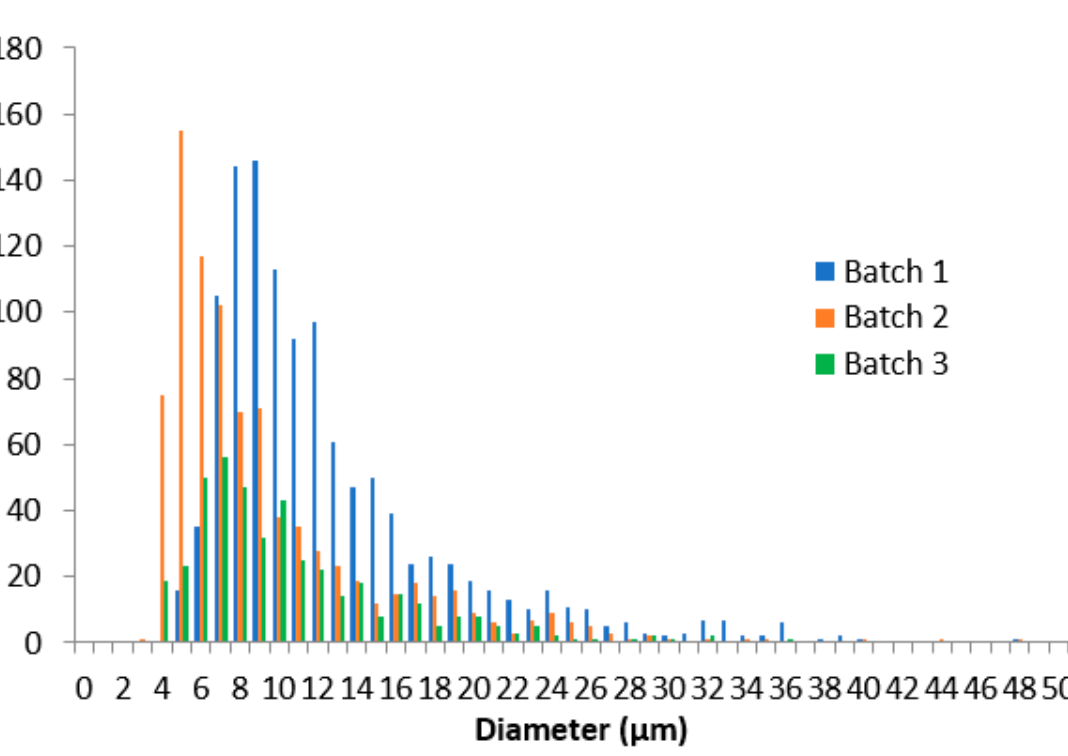
Figure 5. Droplet size distribution of the 0.025% w / w capsaicin emulsion of three different batches.